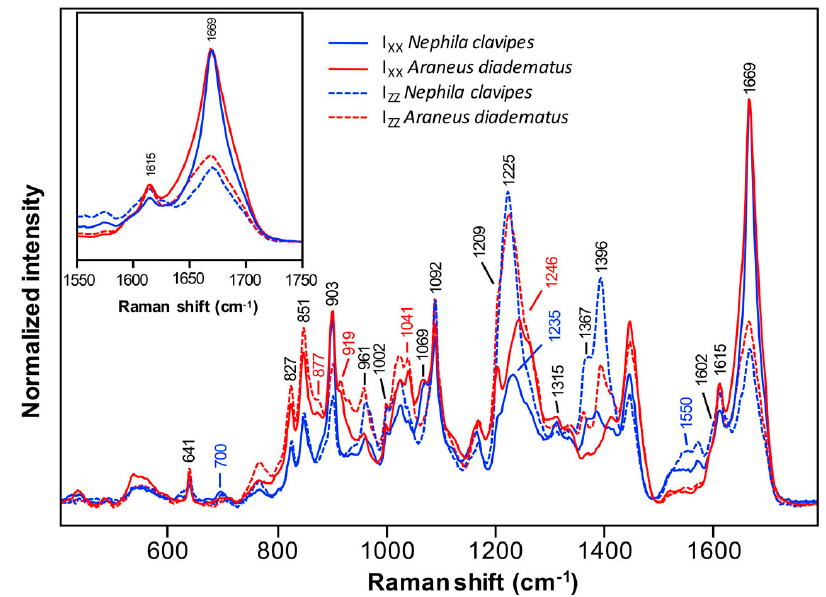
Figure 3. Polarized I XX and I ZZ Raman spectra of Nephila clavipes and Araneus diadematus MA silk fibers. Spectra are normalized so that the I XX peak maximum is equal in the amide I region. They represent the mean spectra calculated over 12–14 series of measurements.